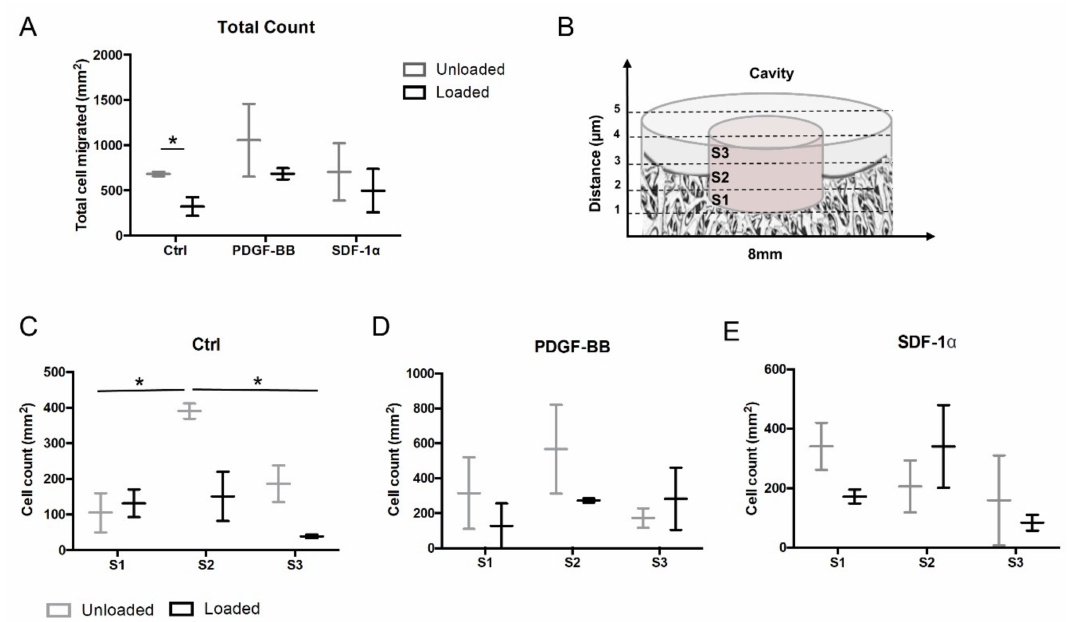
Figure 2. Cell colonization along the osteochondral defect depth. ( A ) Total count of cells invading FB / HA hydrogels into the osteochondral defect explants at day 15 of culture; * p < 0.05. ( B ) Schematic representation of the three di ff erent depth areas of the defect, S1, S2 and S3. ( C – E ) Cell count on histological sections alongside the bone layer S1, intermediate layer S2 and the cartilage layer S3 in the osteochondral defects at 15 days of culture in presence or absence of PDGF-BB or SDF-1 α ; * p < 0.05. Results from three donors (one explant per donor) are